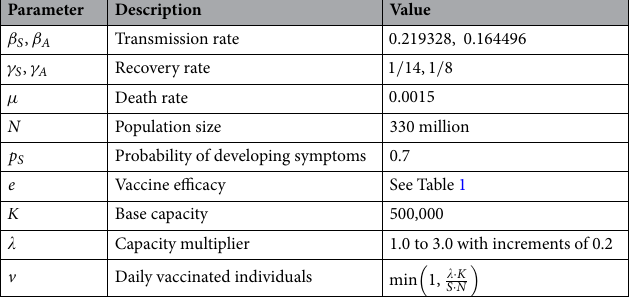
Table 2. Parameters used in the main SIR-D